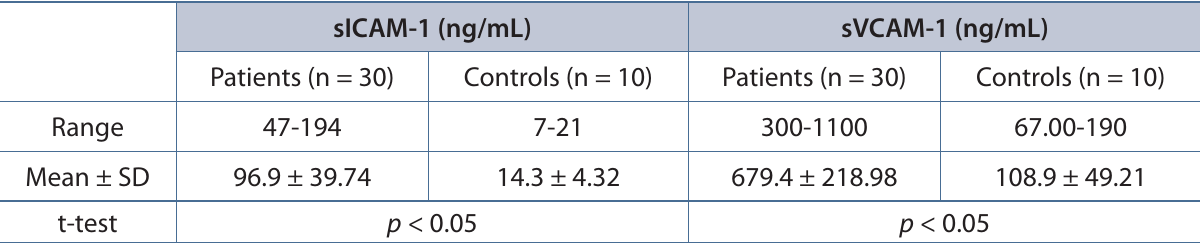
Table 1. Comparison between serum levels of s-ICAM-1 and s-VCAM-1 in CHC group and controls at presentation